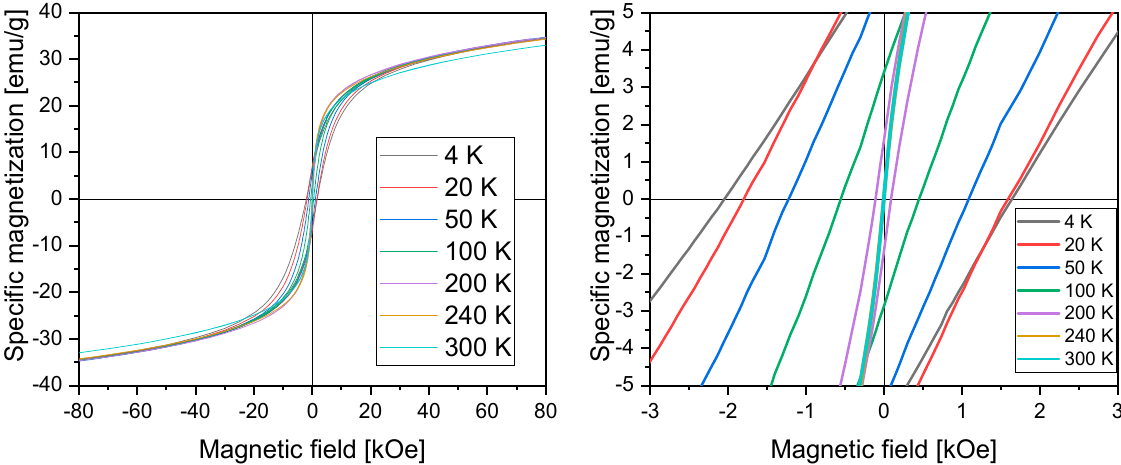
Figure 4. Magnetization vs. magnetic field in the 4–300 K temperature range of magnetic nanoparticles